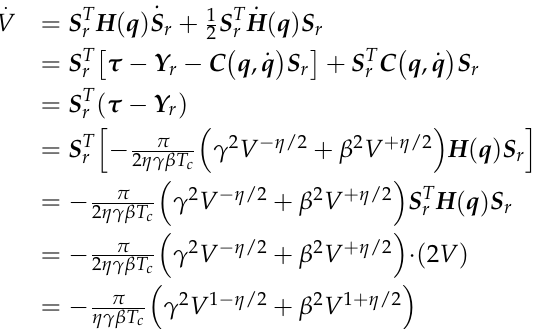
The initial direction of SC for T1 of SA was [5.9 − 2.8] × 10 − 6 rad and SB for T2 of SA was [ − 6.2 7.6] × 10 − 6 rad. The initial direction of SC for T2 of SC was [6 − 10.4] × 10 − 6 µ rad. The total simulation time was 1000 s, and the step size was 0.1